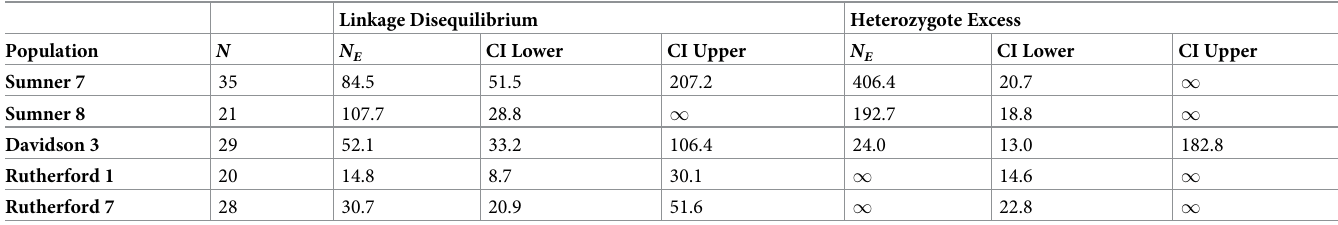
Table 4. Estimates of effective population sizes (N E ) for five populations of Ambystoma barbouri in Tennessee based on the Linkage Disequilibrium (LD) method and the heterozygosity excess method as performed by N e Estimator. The 95% confidence intervals were estimated by the parametric chi-squared